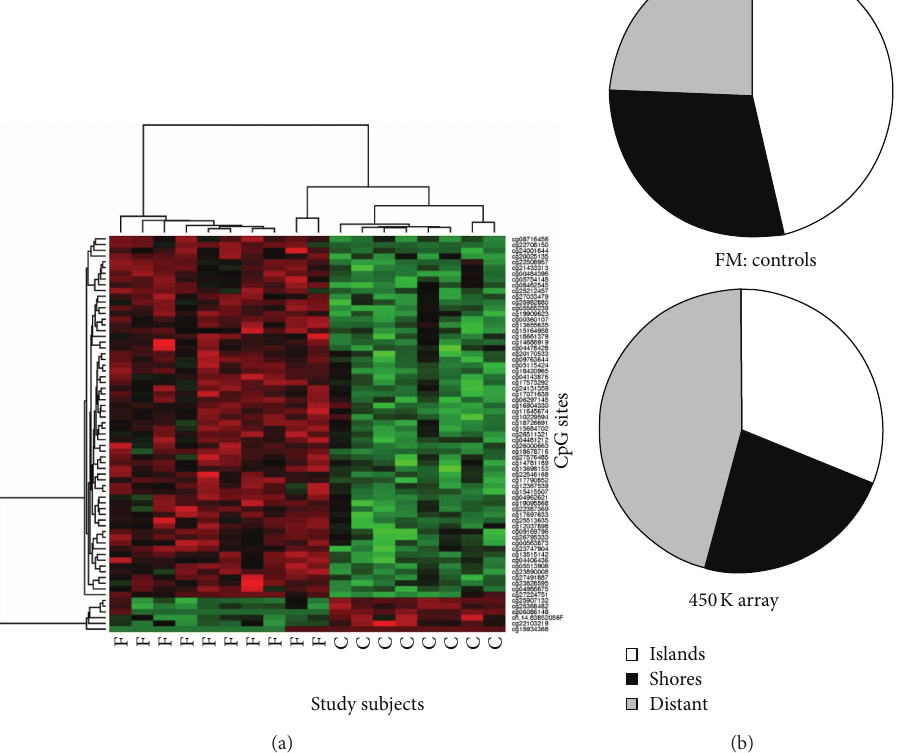
Figure 2: Sites having significantly different methylation patterns in women with FM compared to healthy controls. (a) A heatmap shows the 69 DM sites detected in the study. The women who have FM (F) are grouped on the left of the figure, with controls (C) being grouped on the right. Each row (CpG site) is scaled to represent methylation where lower levels are represented in green while higher levels are represented in red. The majority of significant differences resulted from women with FM (upper left red cluster) having higher levels compared to controls (upper cluster), with a smaller cluster (lower left green) showing lower methylation levels in the cases with FM compared to healthy controls. (b) Pie charts showing the percentage of DM sites according to their relationship to CpG islands. Nearly half (46.4%) of the sites that were significantly different between the women with FM compared to controls were localized to CpG islands (top pie chart), whereas CpG islands account for only about one third (31%) of the sites interrogated on the 450K HumanMethylation array (bottom pie chart). The proportion of DM sites localized to shores that were recognized in this study (29%) closely paralleled the proportion of sites localized to shores that are interrogated in the array (23%). Sites associated with a location distant to CpG islands accounted for 24.5% of the DM sites identified in this study but accounted for 46% of the total sites interrogated on the